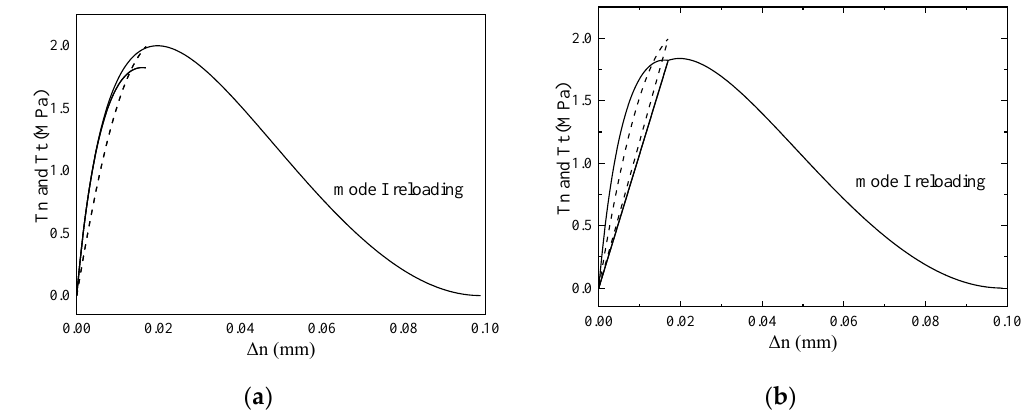
Figure 15. Variations of the traction components 𝑇 𝑛 (solid lines) and 𝑇 𝑡 (dashed lines) during the process of proportional loading/unloading and mode I reloading, for a proportional loading amplitude of Δ = 0.017 mm . Model (i) ( a ) ; model (ii) and model (iii) ( b ).